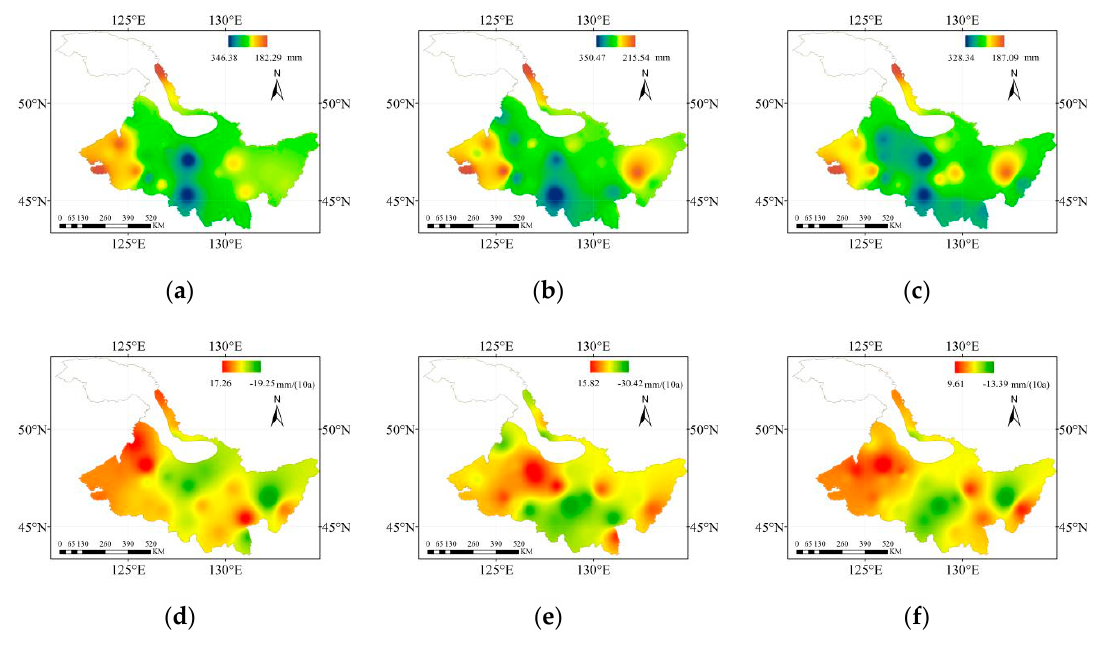
Figure 4. Average effective precipitation ( P e ) during ( a ) 1960–1979, ( b ) 1980–1999, and ( c ) 2000–2015. Figure 4. Average e ff ective precipitation ( P e ) during ( a ) 1960–1979, ( b ) 1980–1999, and ( c )